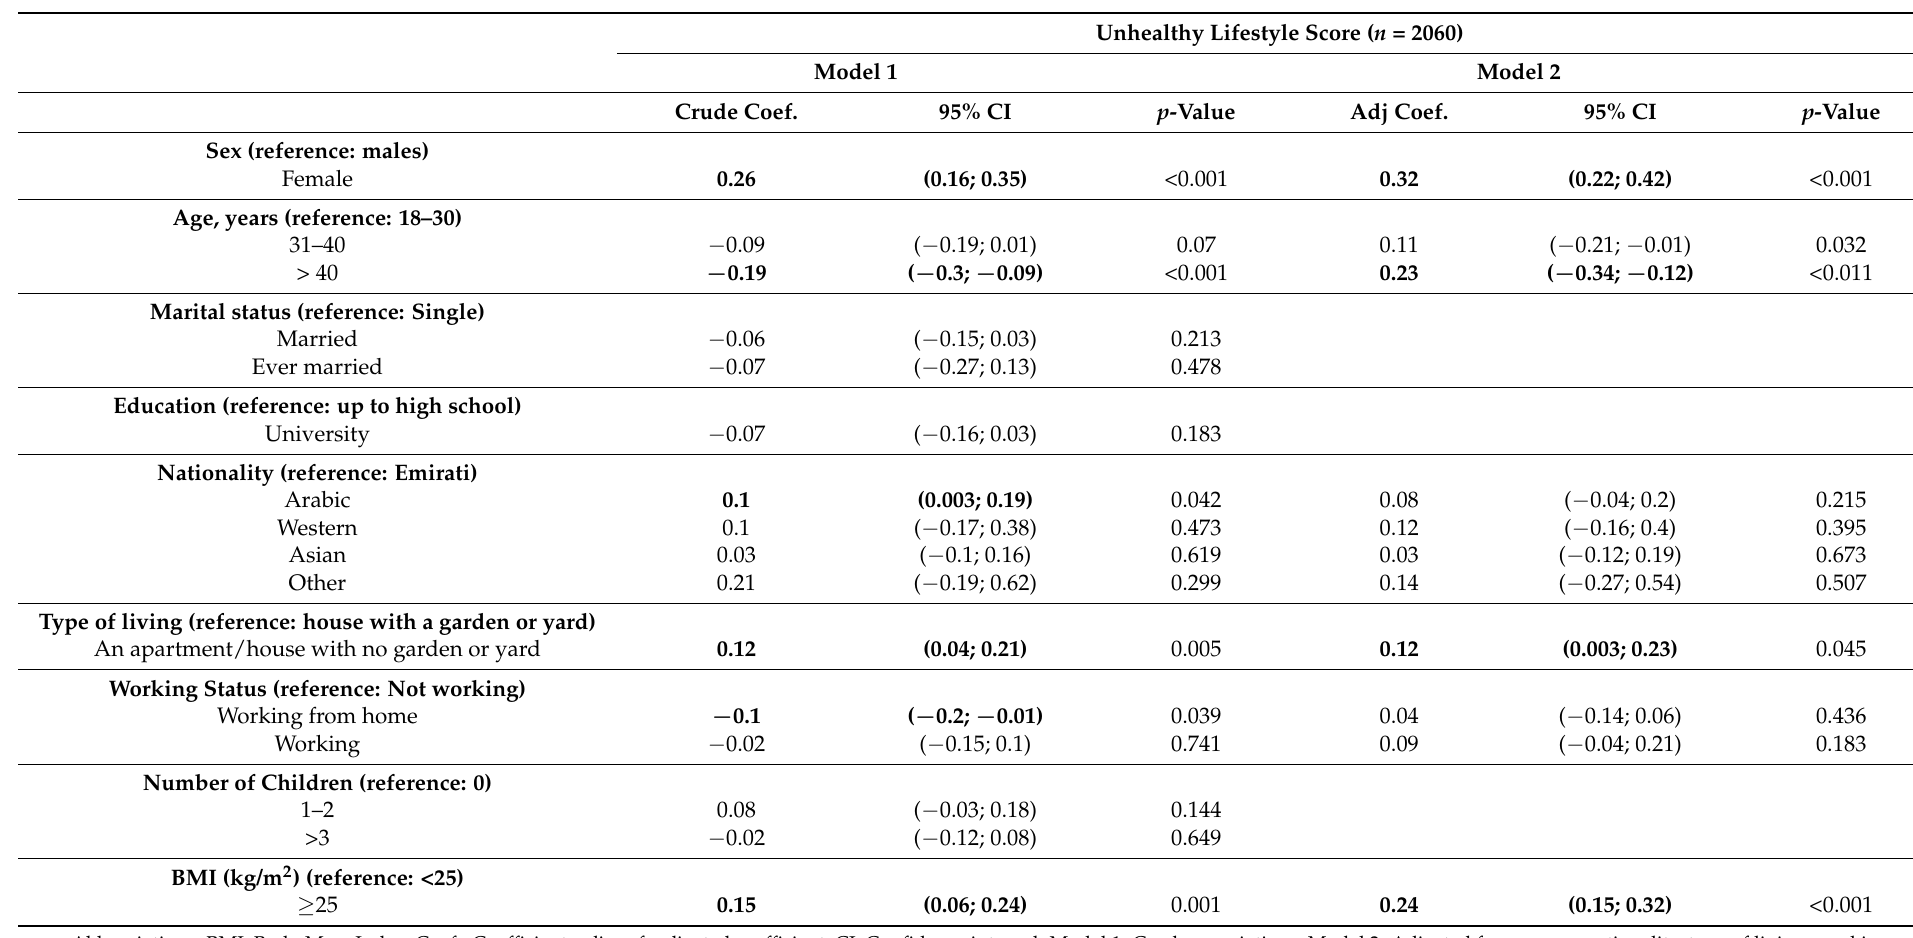
Table 3. Simple and multiple linear regressions describing the association between unhealthy lifestyle score and sociodemographic characteristics in the study population ( n =